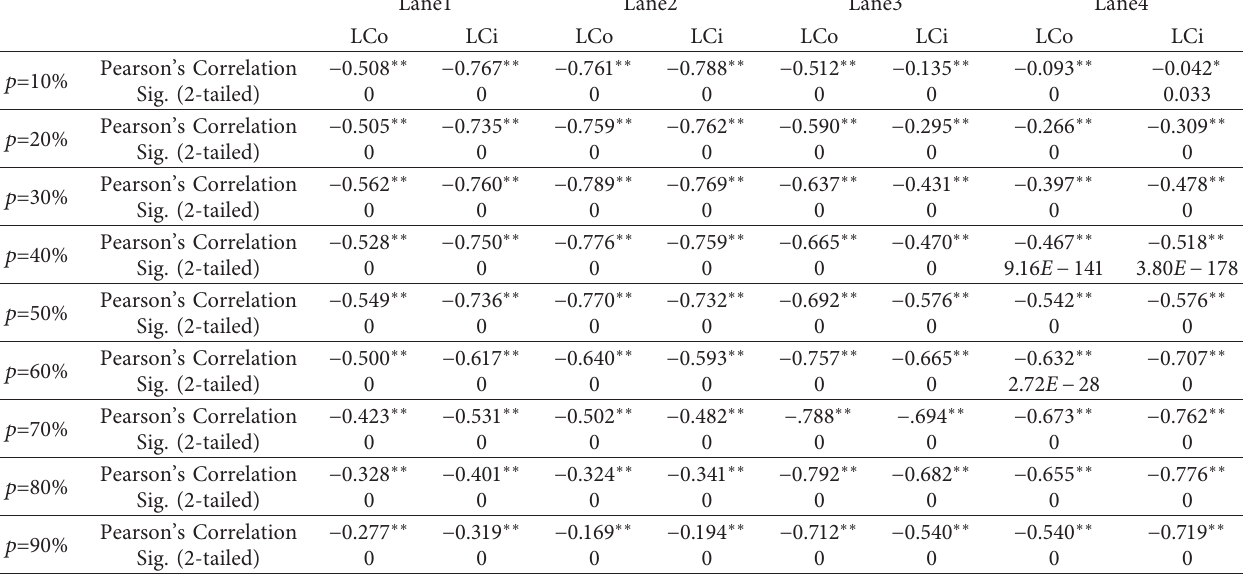
Table 5: The linear correlation table between V, LCi, and